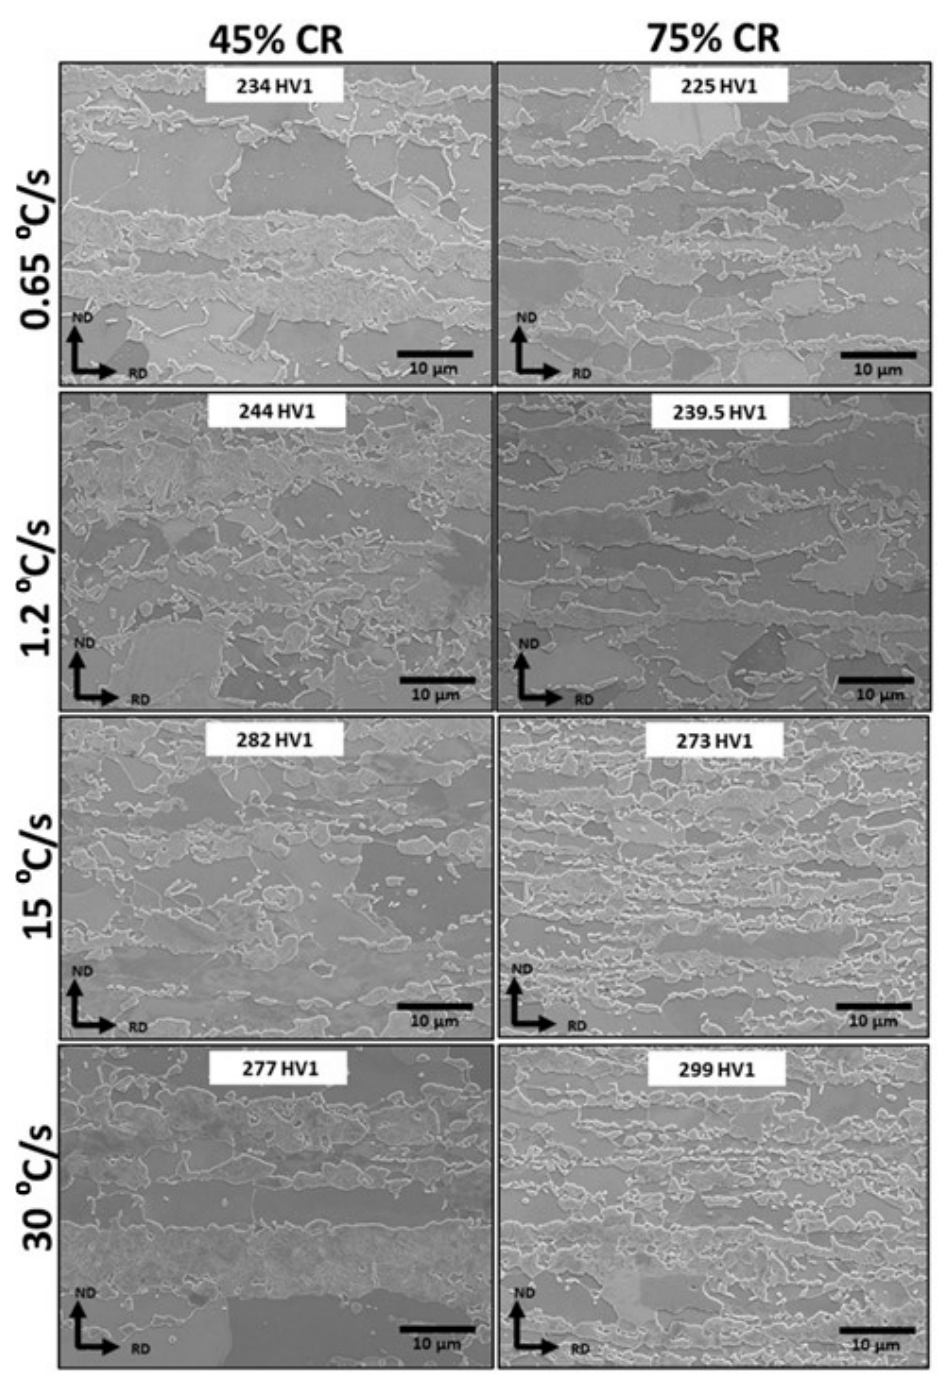
Figure 4. SEM microstructural images and the corresponding hardness values for 45% and 75% Variant 1 cold-reduced samples annealed at heating rates of 0.65 ◦ C/s, 1.2 ◦ C/s (CAPL), 15 ◦ C/s and 30 ◦ C/s, respectively.